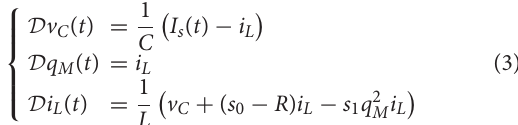
FIGURE 1 | Charge-controlled memristor circuit with R , L , C components and independent current source I s .